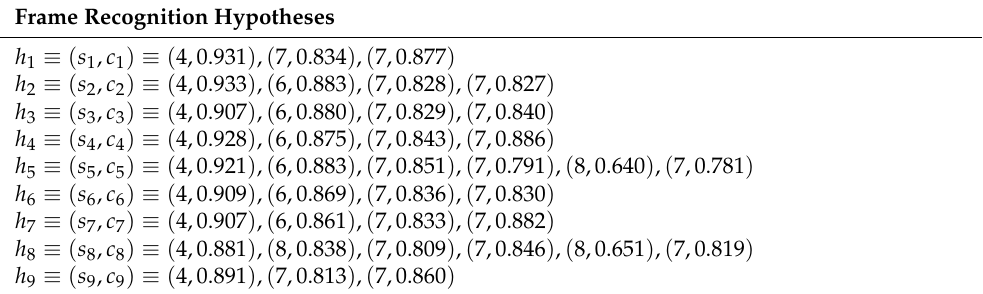
Table 1. For each frame given in Figure 1, a recognition hypothesis is provided. The digit after the decimal point is intentionally discarded. The recognition confidences are normalized to the range [ 0,1 ]